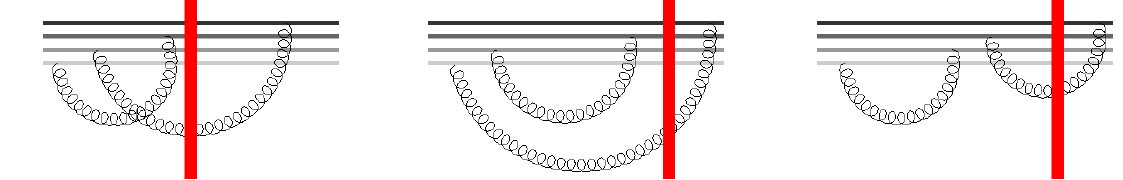
Figure 14 . The diagrams for (cid:6) JJSSJJ .